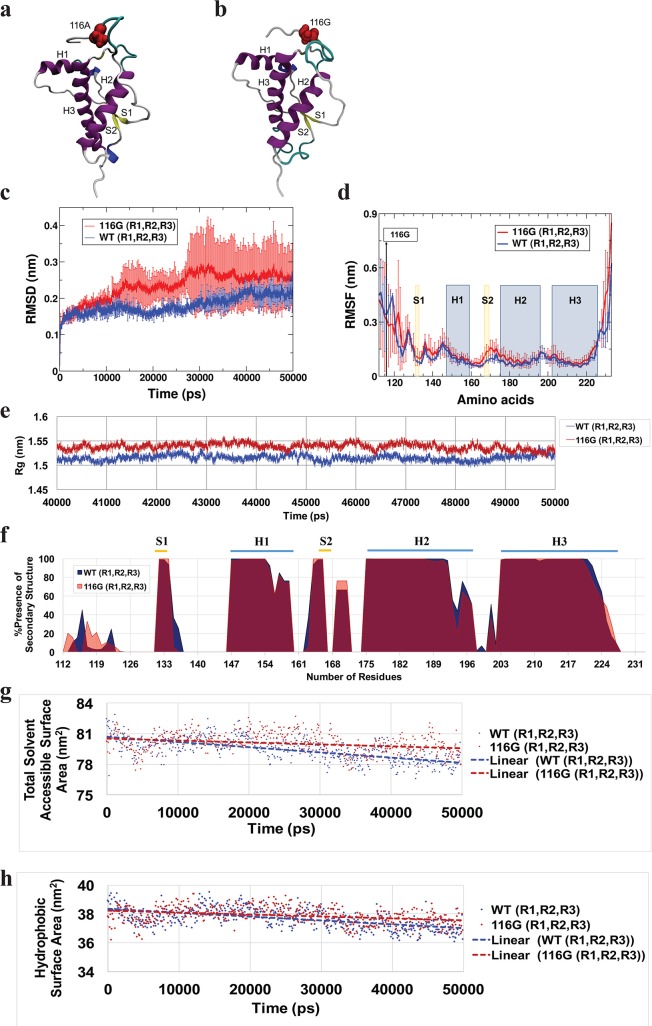
Molecular dynamics simulations.Comparison of wt and 116G PrP via MD simulations. (a) Cartoon representation of wild type PrP (residues 112 to 233): red spheres represent alanine in position 116. H1, H2 and H3 stand for helix one, two, and three, respectively. S1 and S2 stand for β-strands one and two. (b) Cartoon representation of 116G PrP: red spheres represent glycine in position 116. (c) RMSD plot for the folded domains of both wt (blue) and 116G polymorphism (red). (d) RMSF plot comparing wt (blue) and 116G polymorphism (red). The location of the polymorphism at residue 116 is shown with a black line and a label. The yellow and blue bars highlight the location of individual β-strands and α-helices, respectively. Both graphs show the average of three rounds (R1, R2, R3) of simulation. (e) Radius of gyration (Rg) values for both wt (blue) and the 116G polymorphism (red) as a function of simulation time. Both graphs are the average of three rounds (R1, R2, R3) of simulation. (f) Per-residue percentage of dominant secondary structure for the last 20 ns of production simulation. The blue and red graphs represent wt and the 116G polymorphism, respectively. The location of known secondary structure elements are shown using yellow and blue bars (top), on the crystal structure of deer prion protein (PDB ID: 4yxh [66]. (g) Solvent accessible surface area for both 116G PrP and wt PrP. (h) Hydrophobic surface area for both 116G and wt. (g) and (h) both show the average of three rounds (R1, R2, R3) of simulation and the dashed lines represent the linear fit for the solvent accessible surface area and the hydrophobic surface area values, respectively.